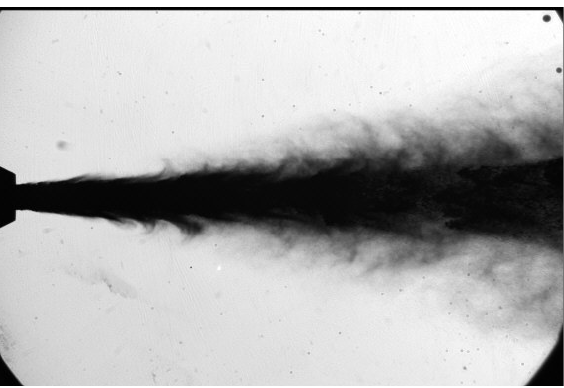
Figure 2. Coaxial liquid-air jet; the credit is due to Mixing Enhancement via Secondary Parallel Injection